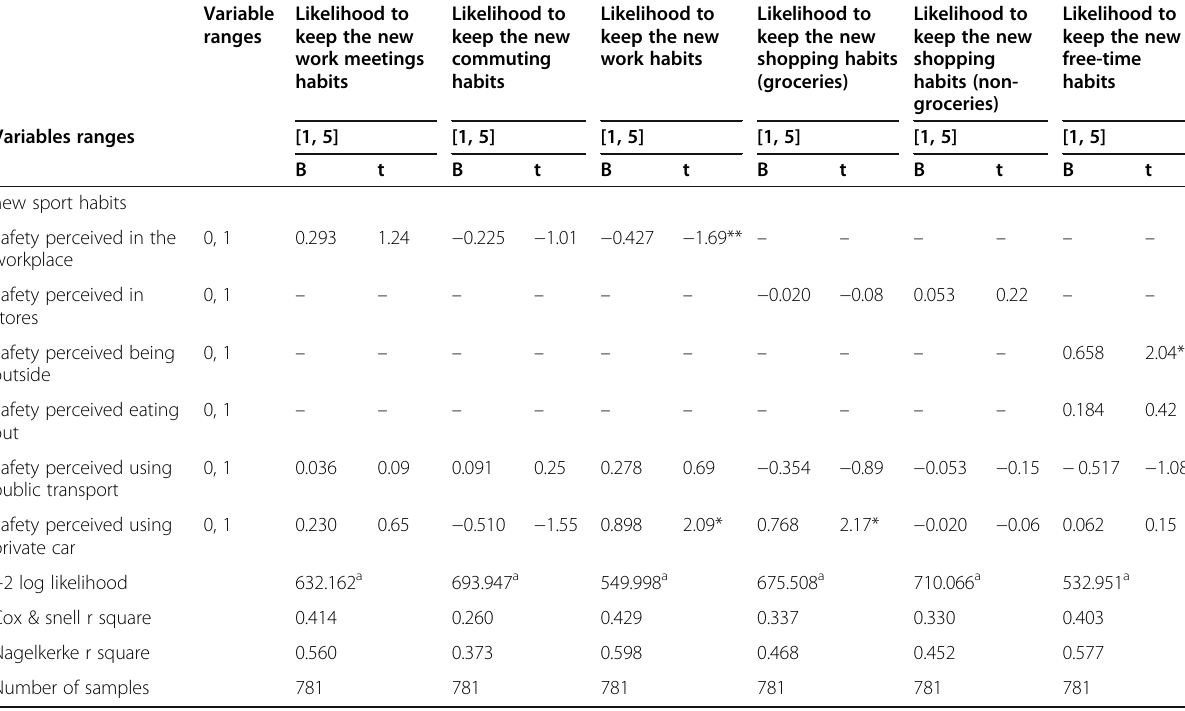
Table 4 Binary logistic regression for a likelihood of keeping the behavioural changes after the pandemic period (Continued) Variable